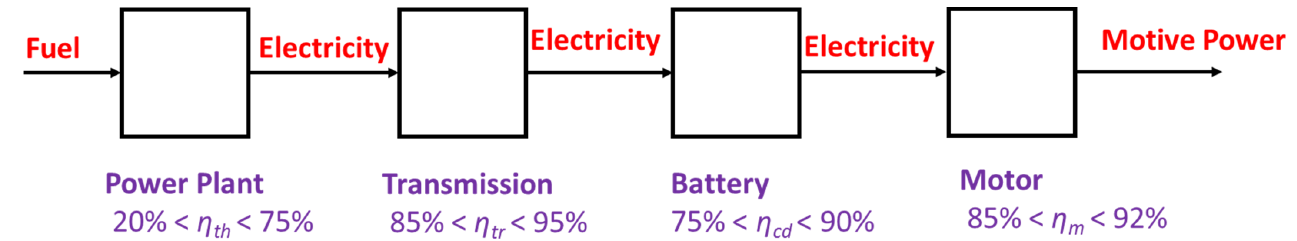
Figure 1. Energy transformation from a primary energy source to the EV motor.